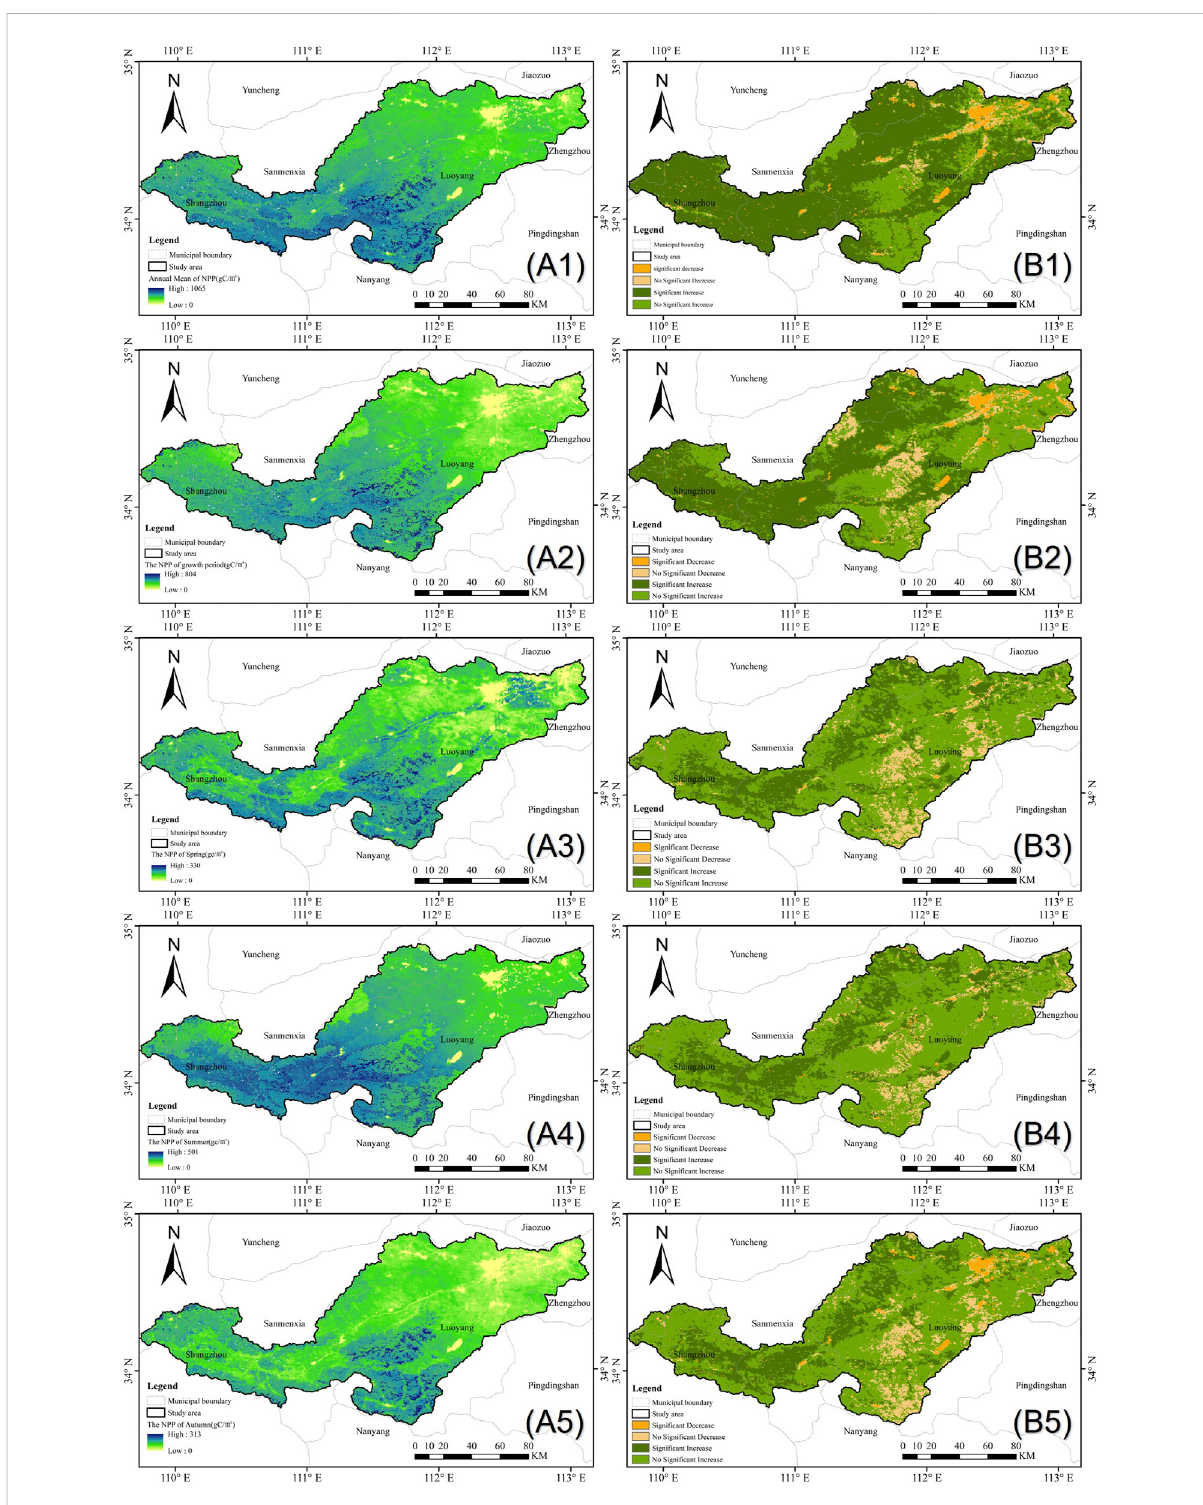
FIGURE 7 Multi-year average spatial distribution (A) and slope trend analysis (B) of NPP at different time scales (1: annual scale; 2: growing season period; 3: spring; 4: summer; 5: autumn) in the